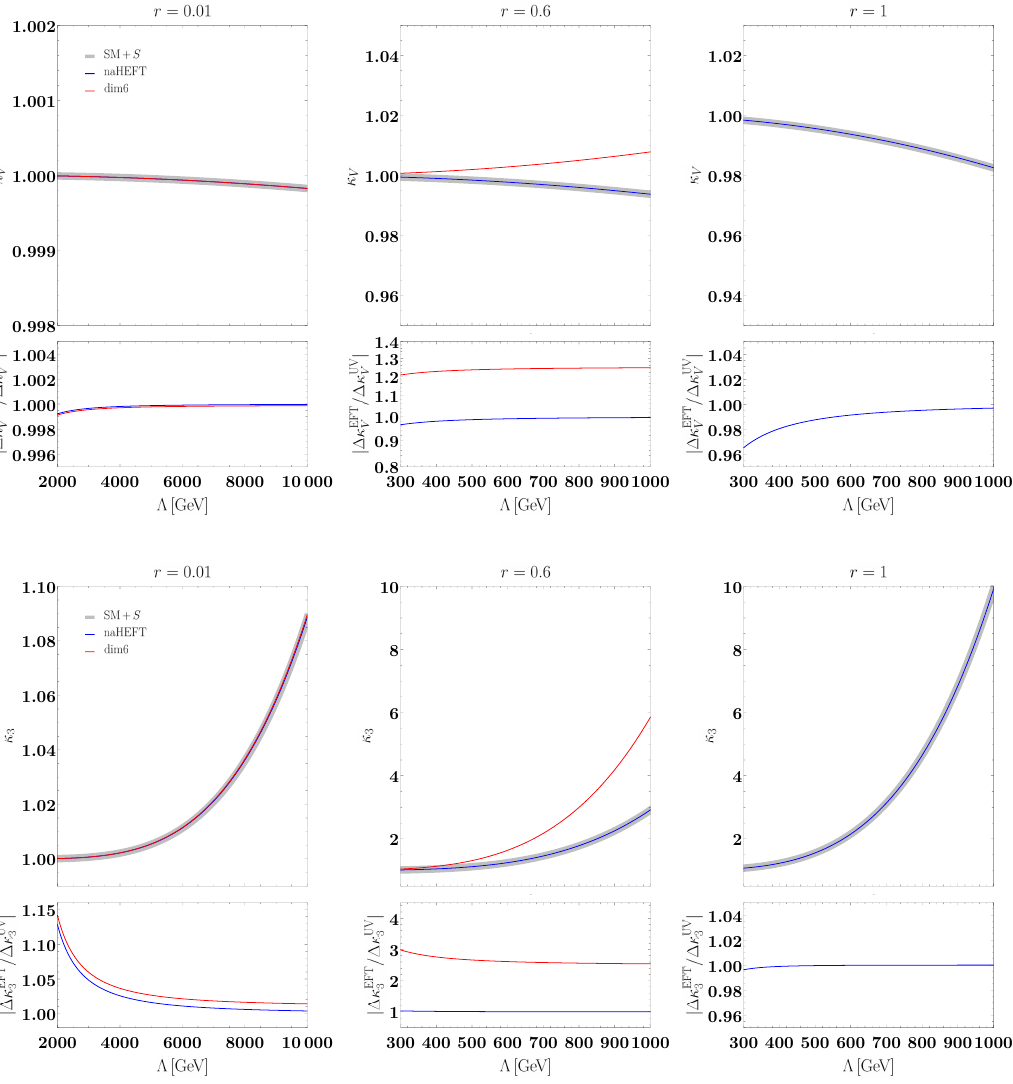
Figure 2 . We compare the various EFT results with the full one-loop results in the renormalizable model reported in refs. [15, 16]. ∆ κ the singlet-loop